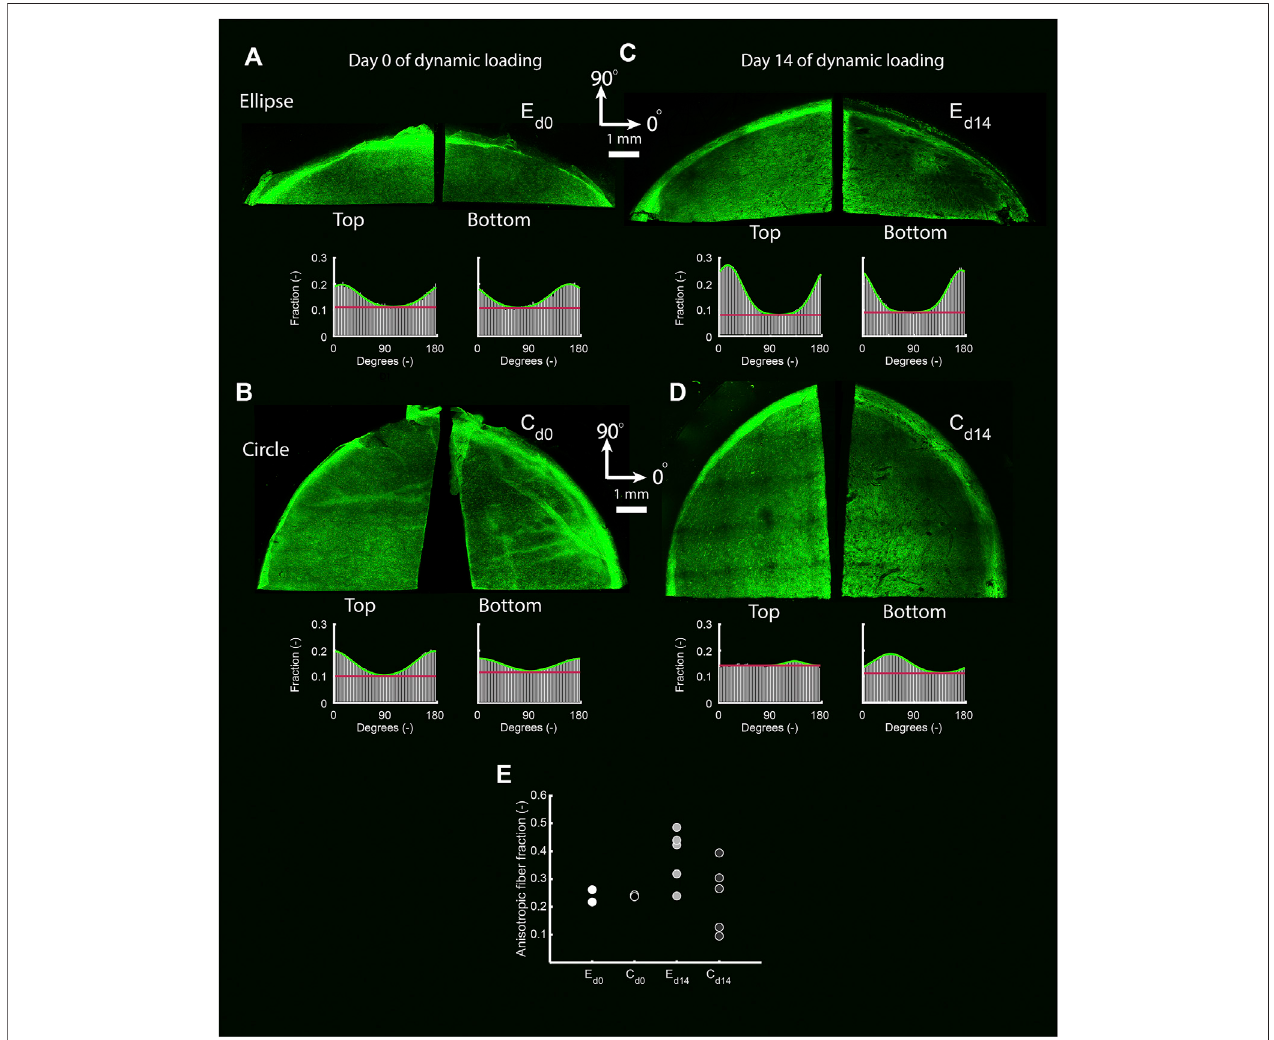
FIGURE 7 | The top and bottom side of representative collagen-stained quarters of elliptical (A,C) and circular (B,D) constructs before (day 0) (A,B) and after (day 14) (C,D) dynamicloading.Thehistogramsindicatethefractionofcollagen fi bersorientedineachdirectionforeachimage.Withinhistograms,thegreenlinerepresentsa Gaussian fi t for the fi ber distribution. The fi ber fraction above the red baseline represents the anisotropic fi ber fraction based on the Gaussian fi t. (E) Average anisotropic fi ber fraction of the top and bottom side of the pre-dynamic loading (d0) elliptical (E) and circular (C) constructs (both n = 2), and the post-dynamic loading (d14) elliptical and circular constructs (both n =